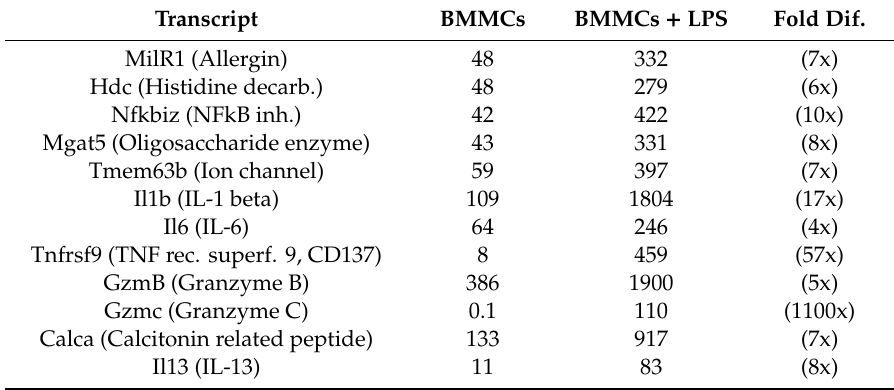
Table 4. Transcripts that are highly upregulated in BMMCs after LPS stimulation (4 h). The table depicts the number of reads for each transcript. The right column depicts the fold di ff erence in transcript levels between BMMCs + LPS vs. unstimulated